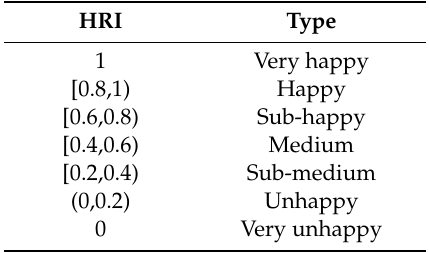
Table 3. Classification of the Happy River Index